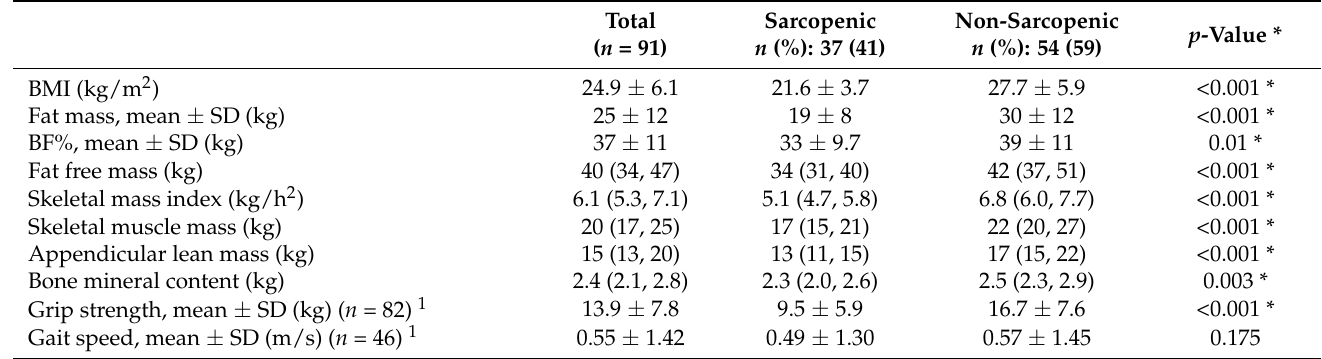
Table 3. The association of sarcopenia with anthropometric, body composition and strength/function